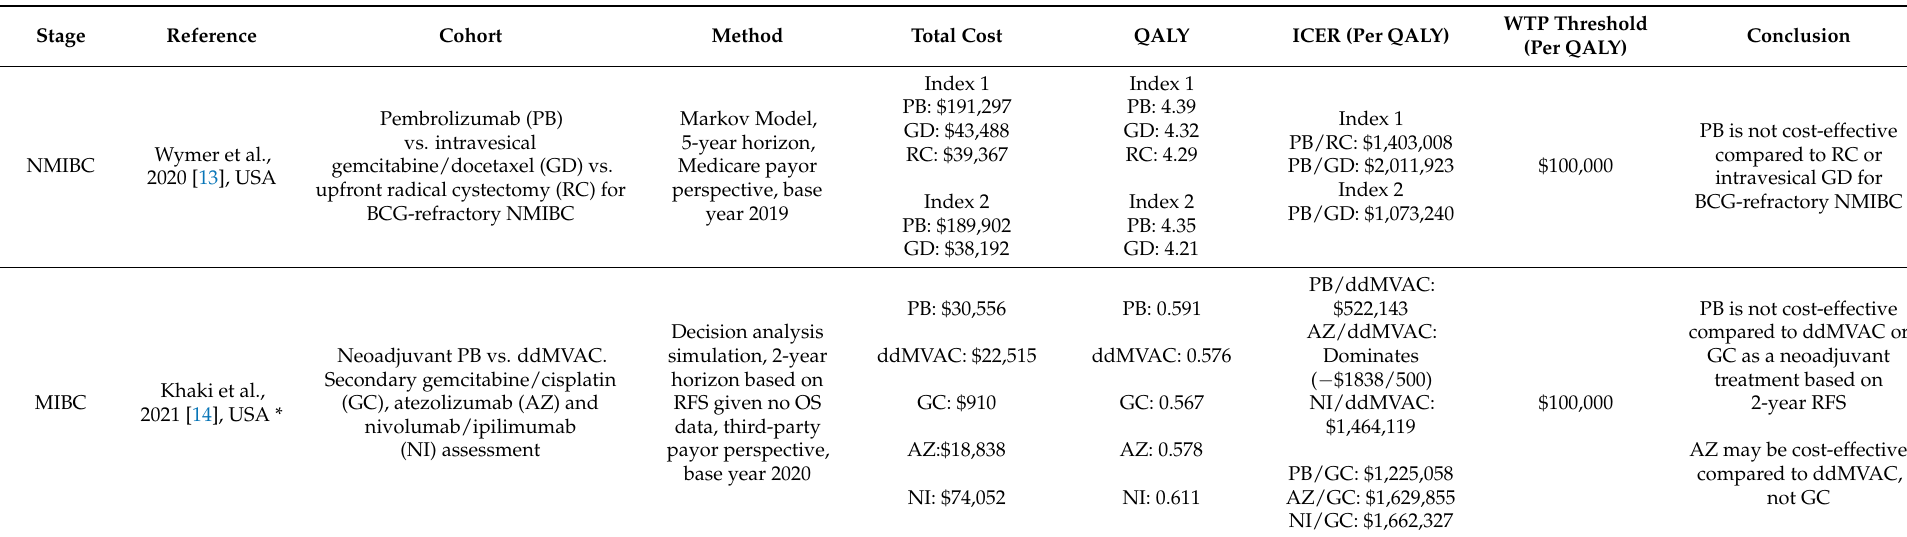
Table 1. CEAs for non-metastatic UC.